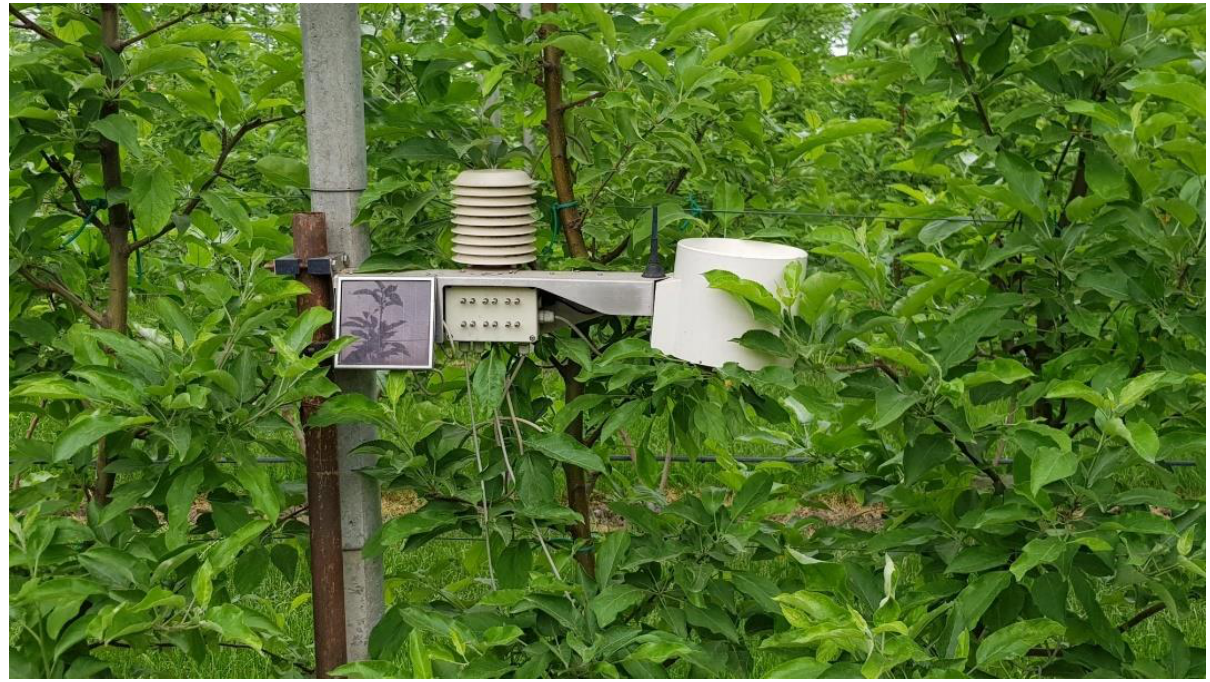
Figure 2. The AWS located inside the canopy air space in the fruit tree row.